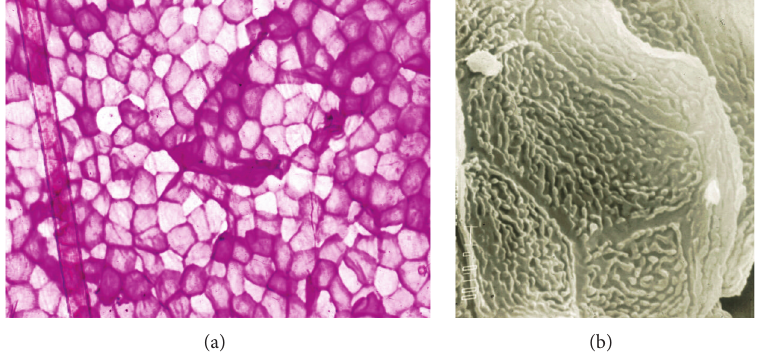
Figure 3: Stratum corneum maturation. (a) Heterogeneity in corneocyte maturation with mature clear cells and immature deeply stained cells. (b) Immature corneocyte with discrete uniform protrusions (scanning electron microscopy).